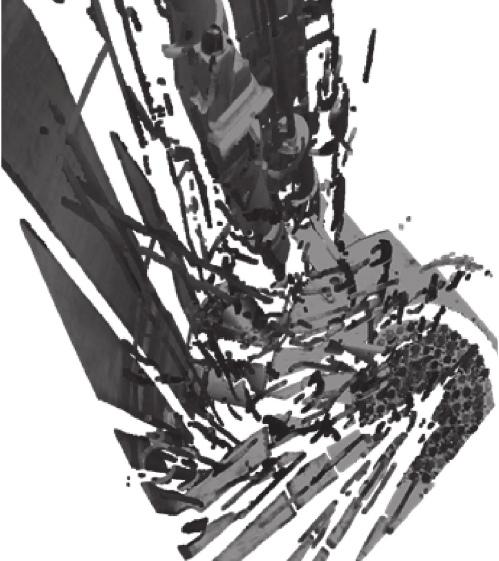
Figure 7: The 3D model of the TRIGA RC1 reactor vessel as acquired with the phase channel of the